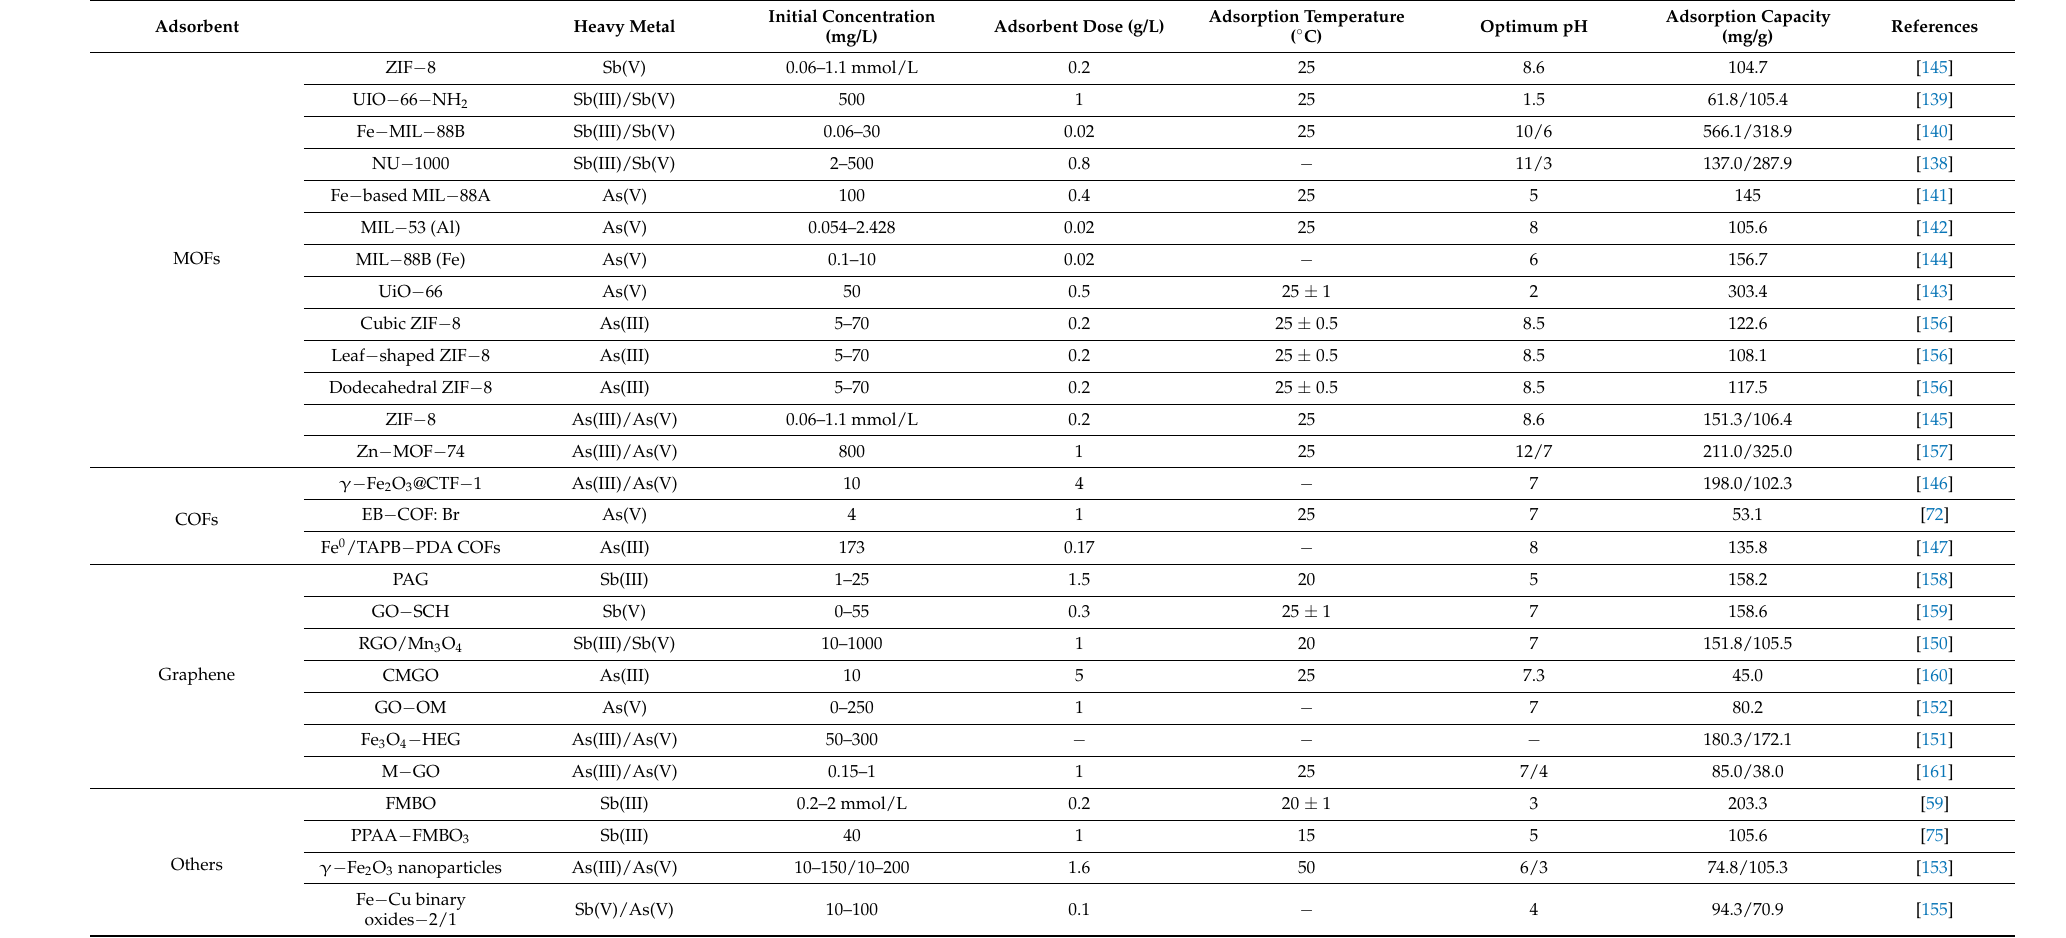
Table 4. Adsorption capacity and other parameters of different frontier adsorbents for removing Sb and